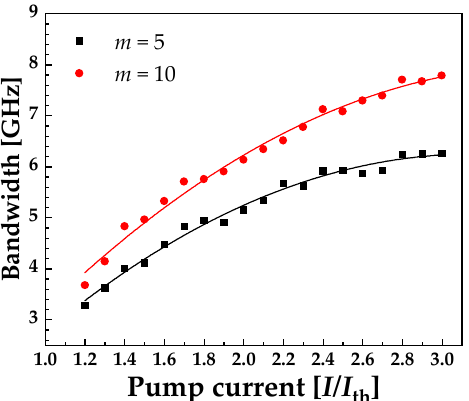
Figure 10. Bandwidth of chaos vs. bias current when f ext = 28% and τ f = 2.4 ns with m = 5 (black squares), m = 10 (red circles).